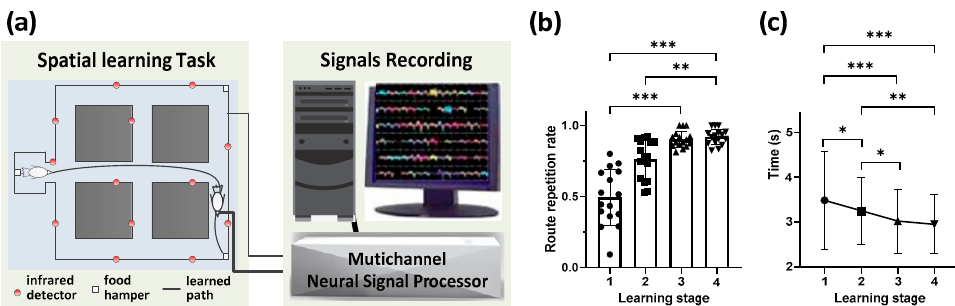
Figure 1. Behavioral performance during route formation in the maze. ( a ) Schematic diagram of the maze. Pigeons learn to find the goal with a food hamper full of grain food from the waiting area. After several navigation trials, pigeons learn the location of the goal. ( b ) Average route repetition rate per stage during route formation (** p < 0.01, *** p < 0.001; Friedman ANOVA; n = 6 animals, 16 sessions). Data are presented as mean ± std. ( c ) Average time spent per trial during route formation (* p < 0.05, ** p < 0.01, *** p < 0.001; Friedman ANOVA; n = 6 animals, 16 sessions). Data are presented as mean ±